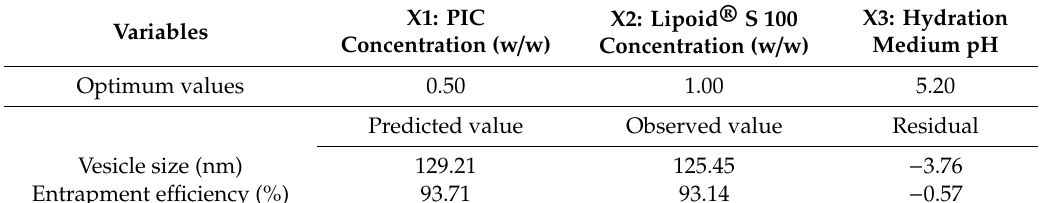
Table 5. Optimized variables’ levels of optimized PIC-E and its predicted and observed responses.